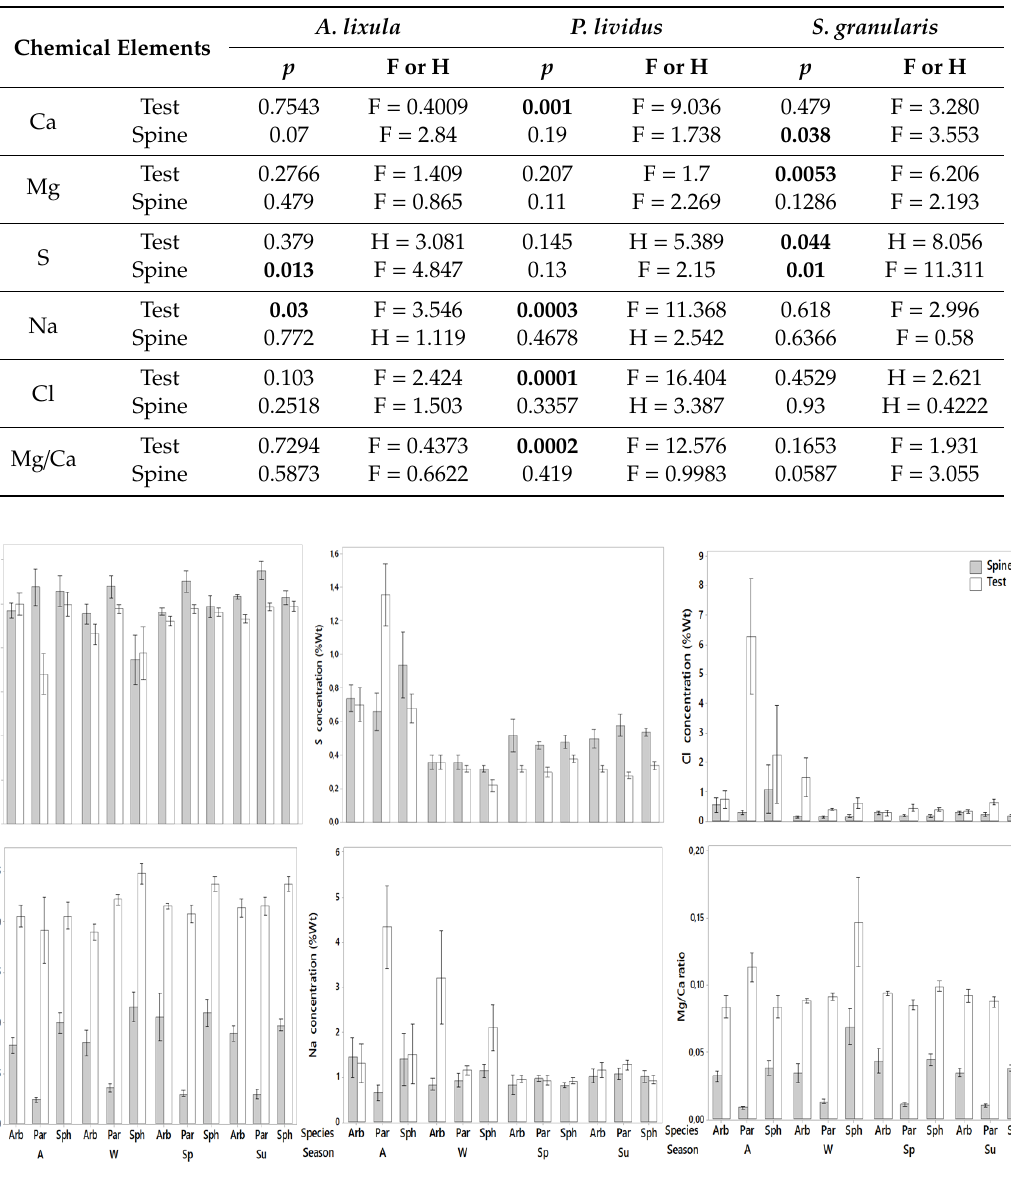
Table 2. Results of one-way ANOVA and Kruskal–Wallis test regarding the temporal variations of each element in the spines and test of A. lixula , P. lividus and S. granularis . Significant di ff erences ( p < 0.05) are highlighted in bold. (F—variance of the group means for ANOVA; H—variance of the group means for Kruskal–Wallis; p : probability value).